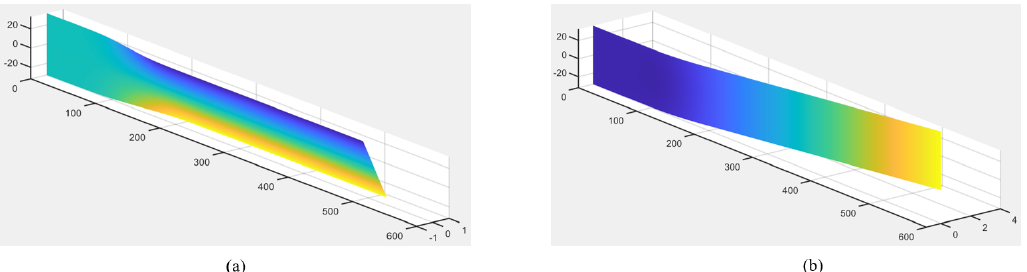
Figure 6. Bending ( a ) and twisting ( b ) shape control effect using different voltages for the actuators.